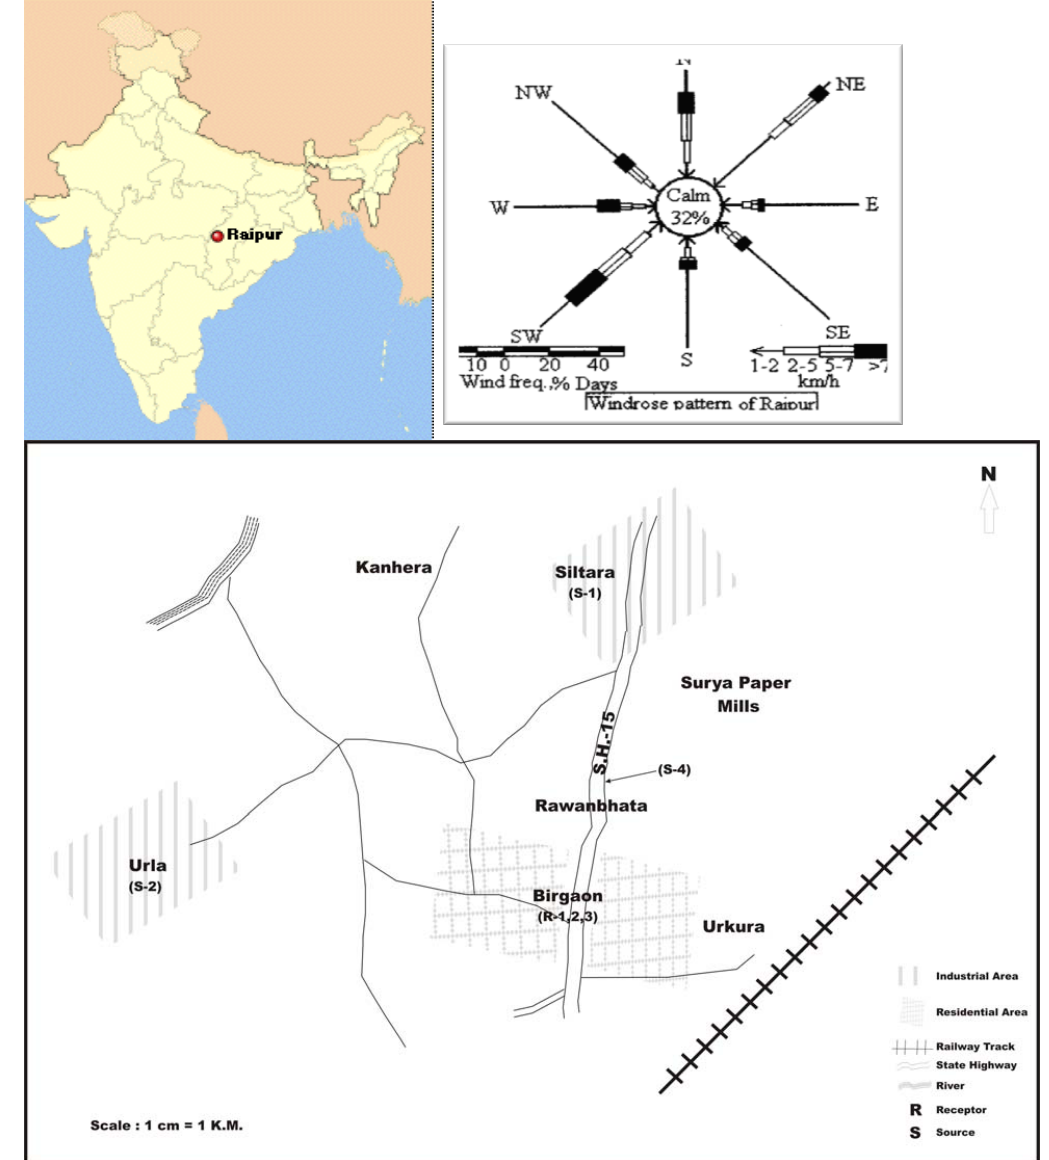
Fig:1 Local map of source and receptor sites in Raipur City along with windrose of the region